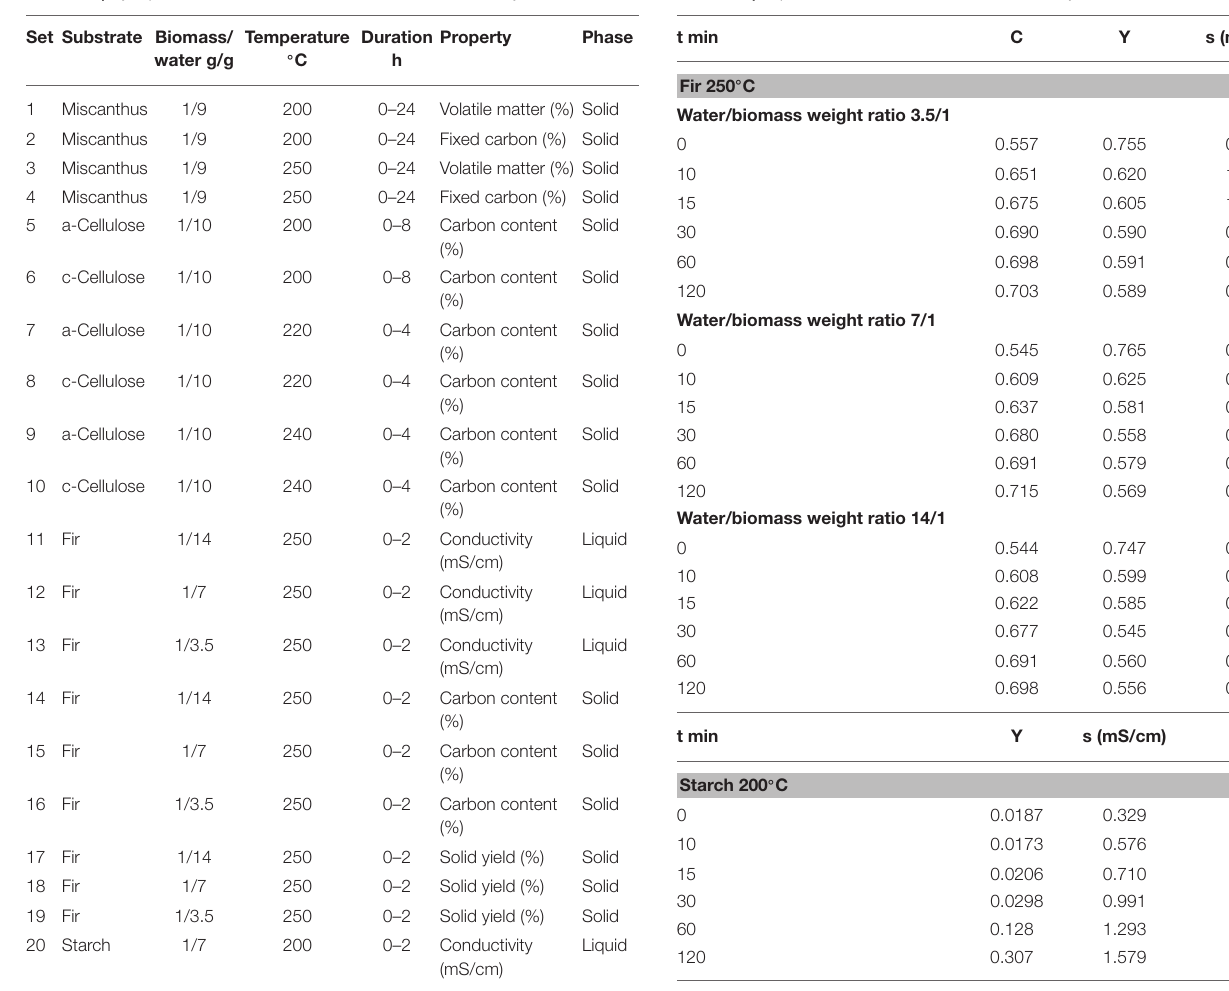
TABLE 2 | Experimental results obtained in this